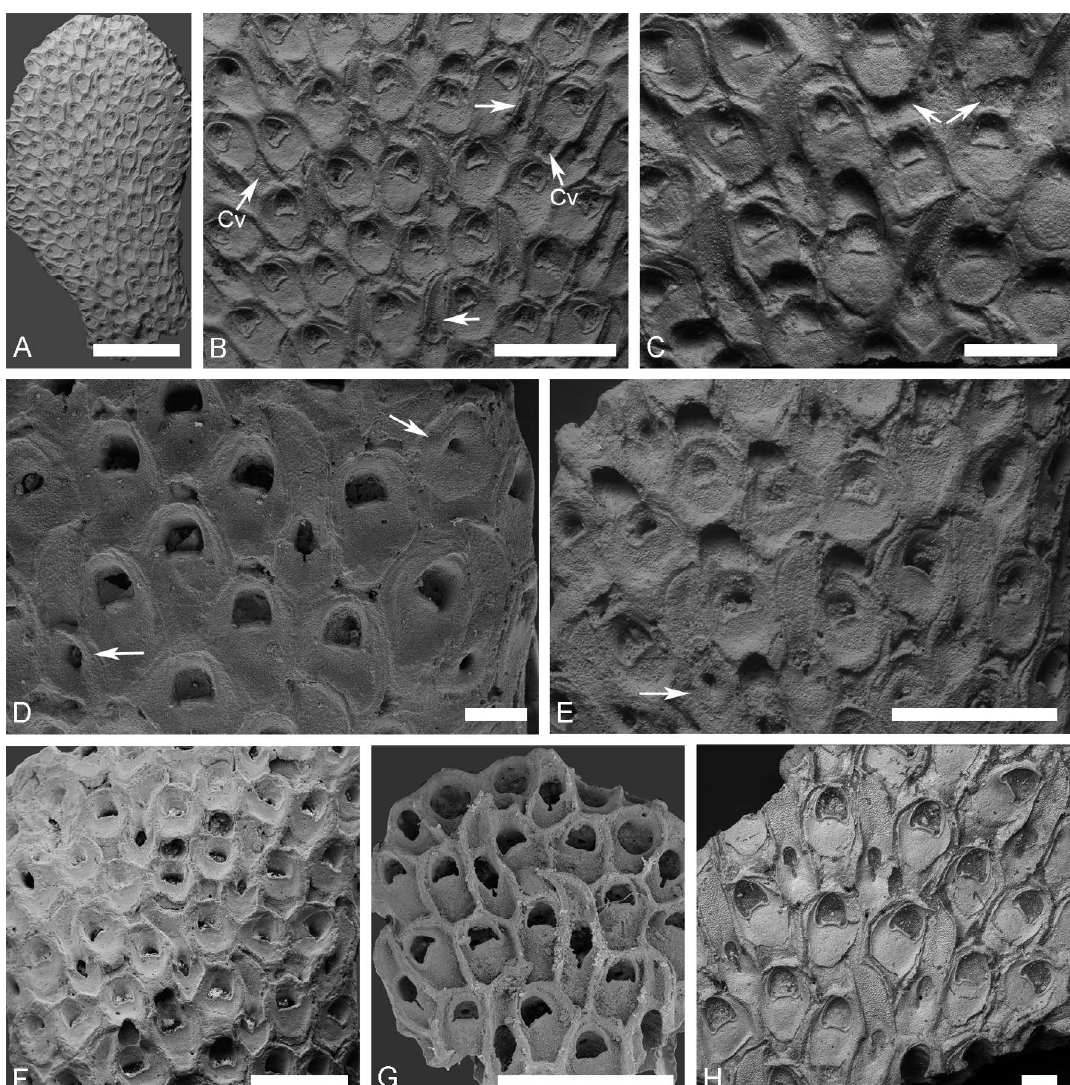
Fig. 7. Rhagasostoma minuens Brydone, 1936. A–C . Coniacian, Chatham, Kent, England, UK. A–B . SMF 29921. A . Overview of erect bifoliate colony. B . Autozooids with proximolateral peripheral caverns (Cv) and broken ooecia, avicularia, and intramural avicularia within host avicularia (arrowed). C . SMF 29922, autozooids with proximolateral peripheral caverns (arrowed) and broken ooecia (some with reparative sutures). D . SMF 29920, early Campanian, Harnham, SW of Salisbury, Wiltshire, England, UK; non-ovicellate autozooids, some with proximal peripheral caverns, and avicularia; intramural kenozooids observed within host autozooid and avicularia (arrowed). E–F . Early Campanian, Meeching Quarry, Newhaven, East Sussex, England, UK. E . SMF 29943, ovicellate (with broken ooecia) and non-ovicellate autozooids, some with proximal peripheral caverns, avicularia, and intramural kenozooid within a host avicularium (arrowed). F . SMF 29944, ovicellate (with broken ooecia) and non-ovicellate autozooids with proximal peripheral caverns and avicularia. G . SMF 29918, Campanian, Hanches, France, overview of bifoliate colony showing autozooids and avicularia. H . SM B36678, specimen (a), late Campanian to early Maastrichtian ( Ostrea lunata Zone) [middle Campanian ( Belemnitella mucronata Zone), Weybourne, Norfolk, in SM database], Trimingham, Norfolk, England, UK; autozooids with peripheral caverns surrounding the cryptocyst and avicularia. Scale bars: A = 2 mm; B, E–G = 1 mm; C = 500 µm; D = 300 µm; H = 200